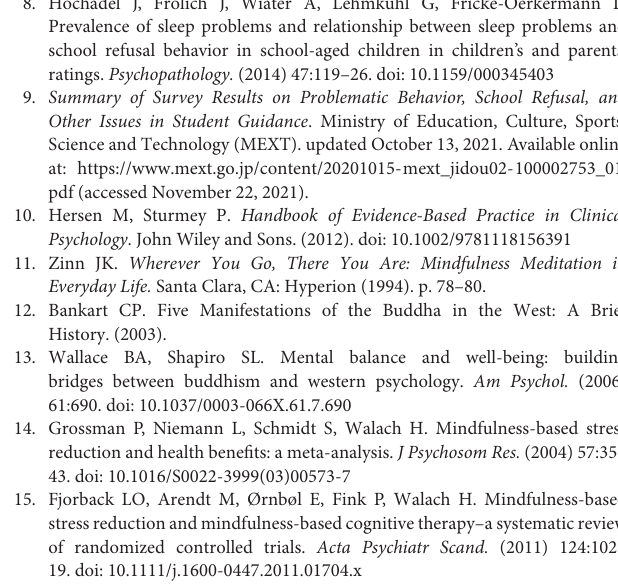
Supplementary Figure 1A | Contents of the first day of the first week of the program. Supplementary Figure 1B | Contents of days 2 through 7 of the first week of the program. Supplementary Figure 1C | Contents of days 8 through 14 of the second week of the program. Supplementary Figure 1D | Contents of days 15 through 21 of the third week of the program. Supplementary Figure 1E | Contents of days 15 through 21 of the fourth week of the program. Supplementary Figure 2A | Contents of the diary of the first week. Supplementary Figure 2B | Contents of the diary of the second week. Supplementary Figure 2C | Contents of the diary of the third week. Supplementary Figure 2D | Contents of the diary of the fourth week. Supplementary Figure 3 | An activity record